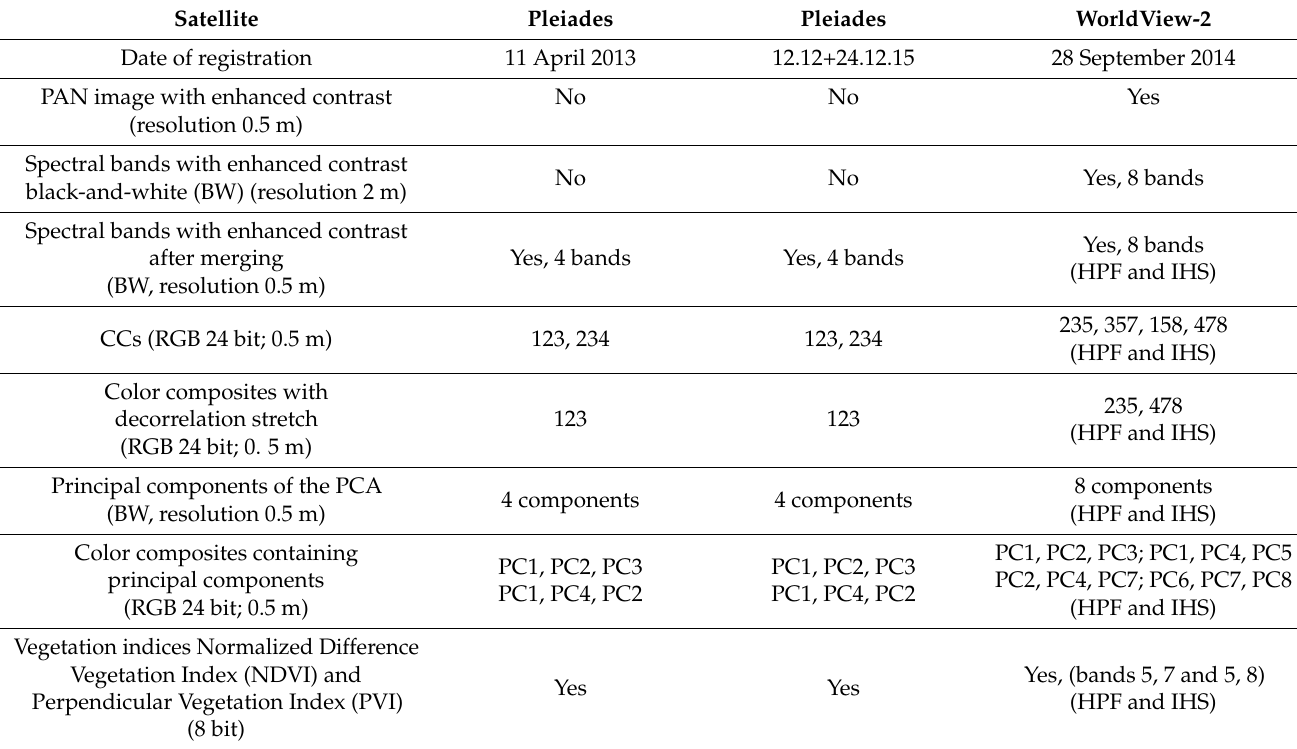
Table 6. Summary list of materials prepared for the visual interpretation.